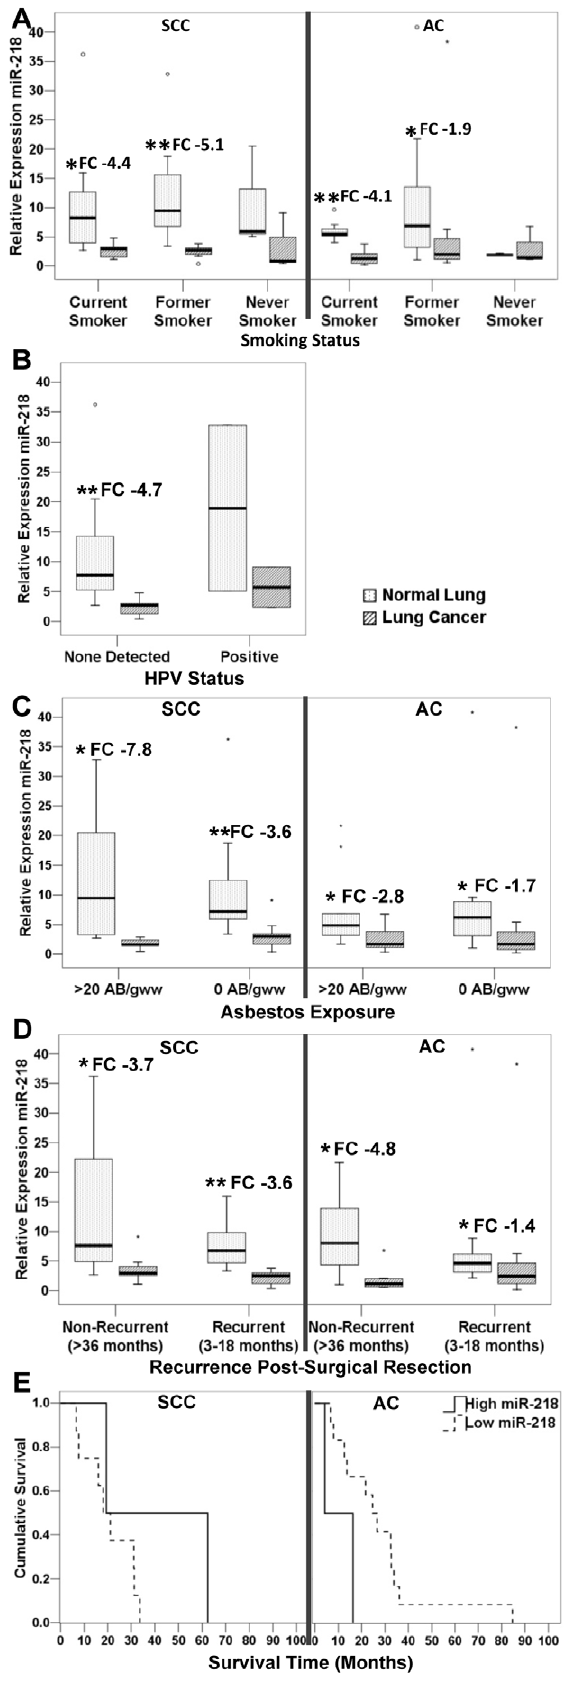
Figure 3. Relationship of miR-218 expression to smoking (a), HPV (b), asbestos (c), recurrence (d) and survival (e). * p=0.05; ** p=0.01. Abbreviations: FC, Fold change. Statistically significant downregulation of miR-218 expression was observed in current and former smokers of both NSCLC subtypes. No significant associations were observed between miR-218 expression and HPV, asbestos, disease recurrence or survival.